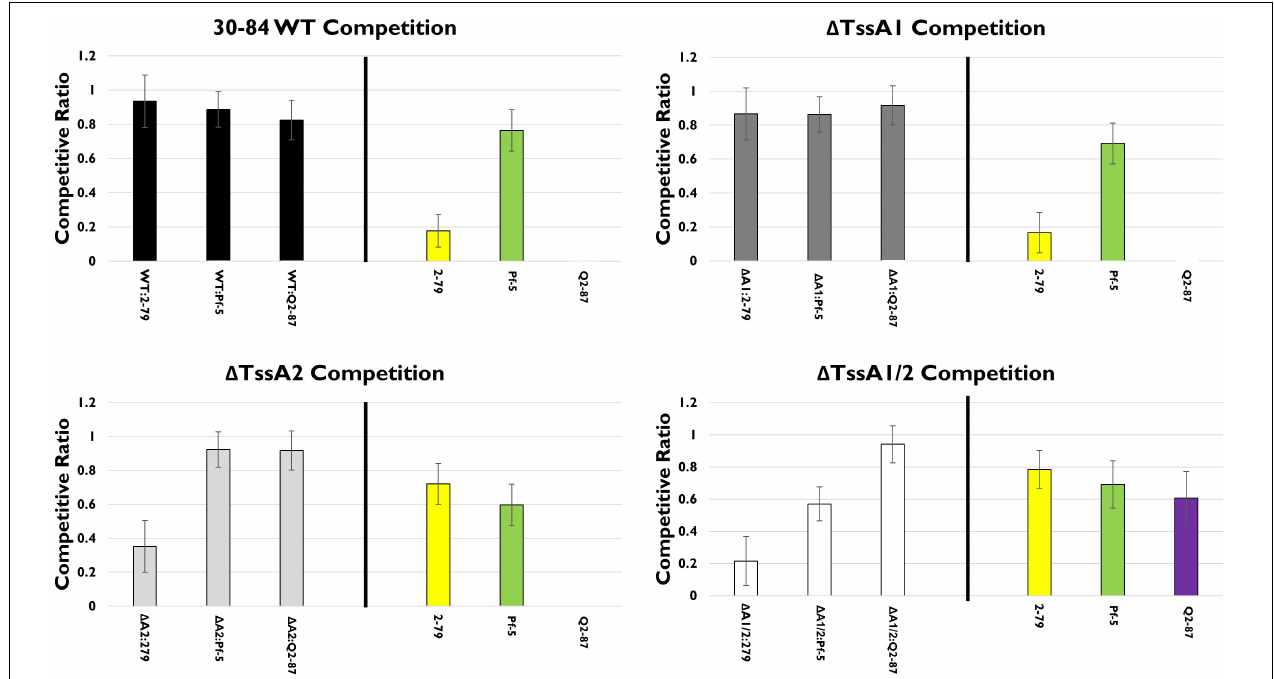
FIGURE 3 | In vitro competition assays. The competitive fitness of 30–84 WT, the single T6SS mutants, (cid:49) TssA1 and (cid:49) TssA2, and the double mutant, (cid:49) TssA1/2 were evaluated by comparing their populations when grown separately or in 50:50 mixtures with other Pseudomonas rhizosphere colonizing bacteria in liquid media. Data are expressed as competitive ratios (population in mixture/population when grown separately). Gray scale bars (left) indicate performance of 30–84 WT and derivatives, and colored bars (right) indicate performance of competitors, including P. fluorescens 2–79 (yellow color, having no T6SS), P. protegens Pf-5 (green color, having a T6SS-1 homolog), and P. fluorescens Q2–87 (purple color, having three T6SS, including T6SS-1 and T6SS-2 homologs). Individual bacterial cultures or mixture cultures were spotted onto nitrocellulose filters on LB plates and incubated at 28 ◦ C, 5 h. Bacterial cells were washed from filters, collected via centrifugation, and populations were enumerated after 48 h via serial dilution plating. Data are the mean competitive ratios of five replicates pooled across three experiments ( n = 15) and standard errors are